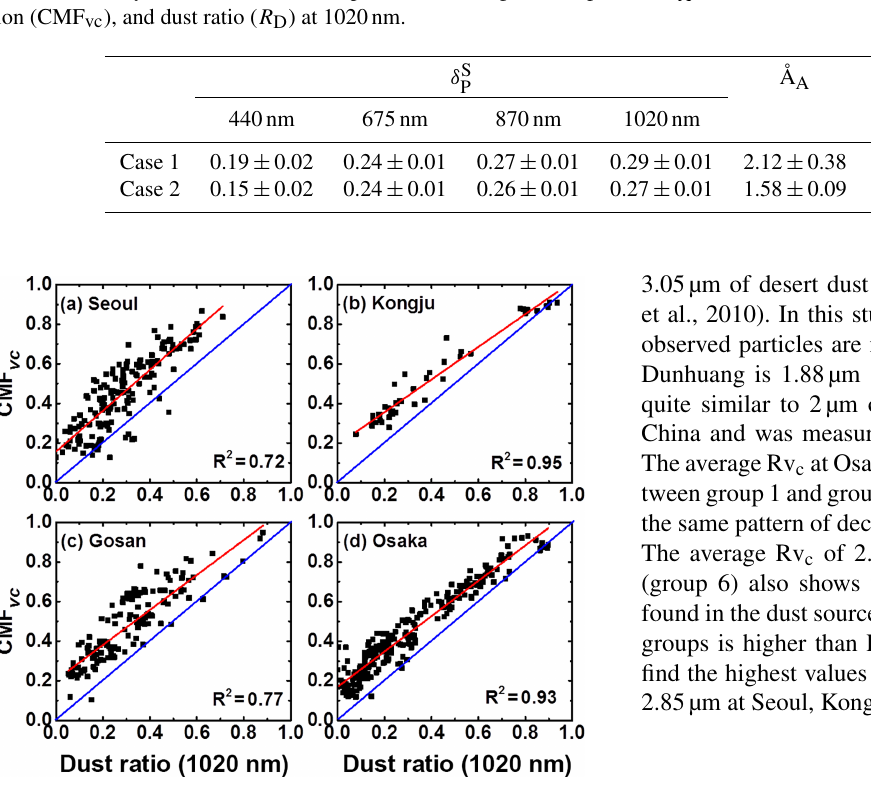
Figure 15. Correlation plots of the dust ratio at 1020nm vs. the volume concentration in the coarse-mode fraction of the particle size